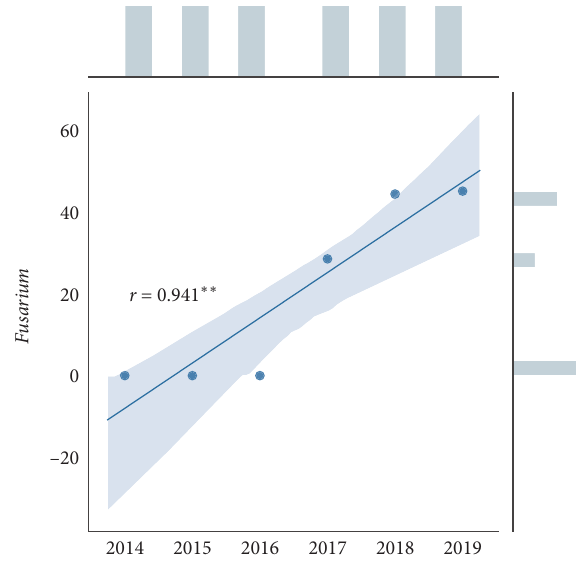
Figure 5: Spearman’s correlation coefficients— Fusarium .